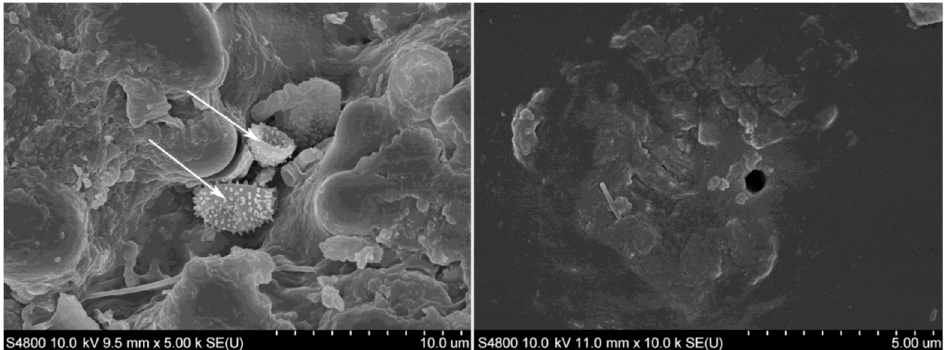
Figure 13. SEM images of ( a ) DS epidermis and ( b ) PA